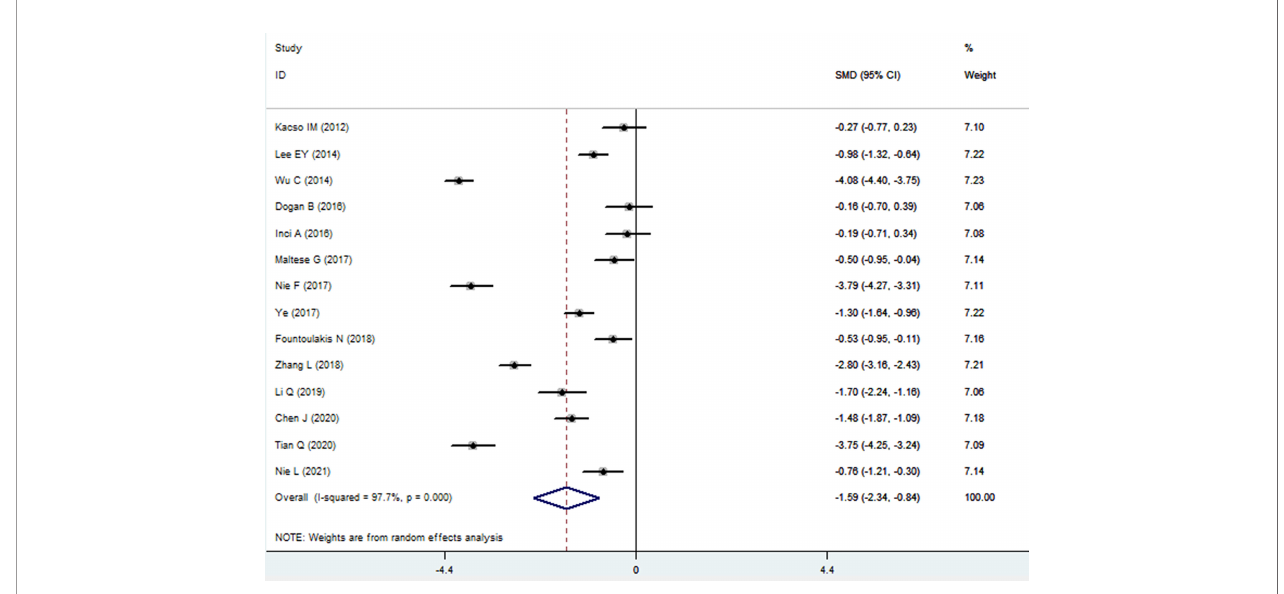
FIGURE 2 | Forest plots and funnel plots of sKlotho level in patients with diabetic nephropathy compared to diabetes. Diamond represents the pooled SMDs at 95% CI. SMD, standardized mean difference; CI, con fi dence